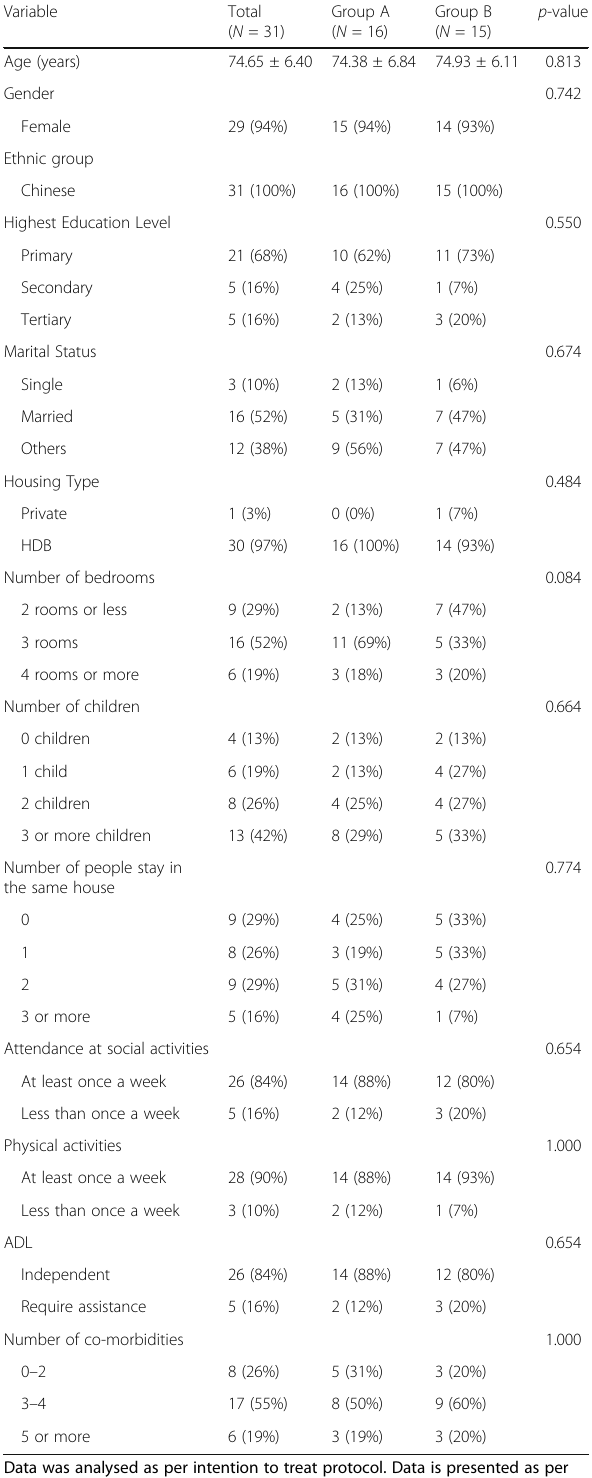
Table 1 Participants ’ socio-demographic characteristics at